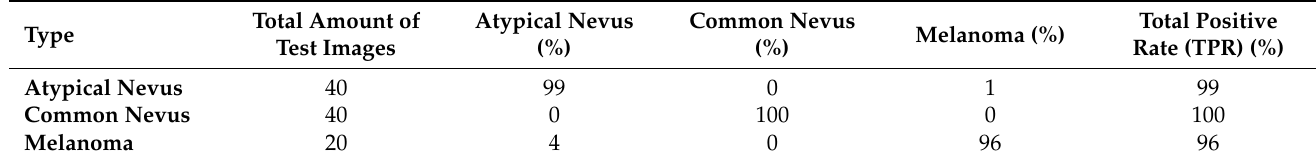
Table 2. PH2 dataset confusion matrix.